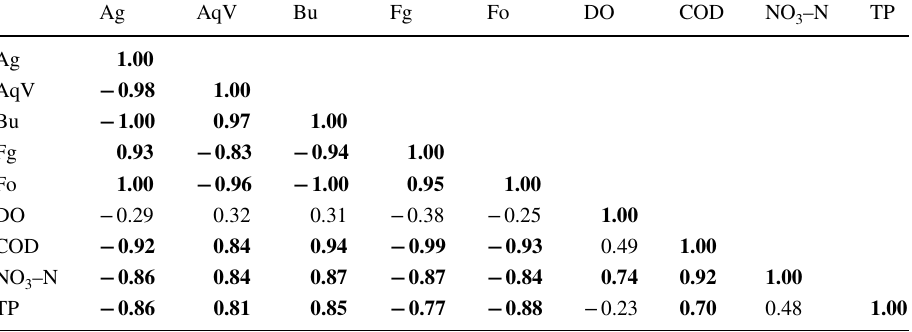
Table 4 Correlation matrix between WQ parameters and LULC for 1992, 2000, 2010, and